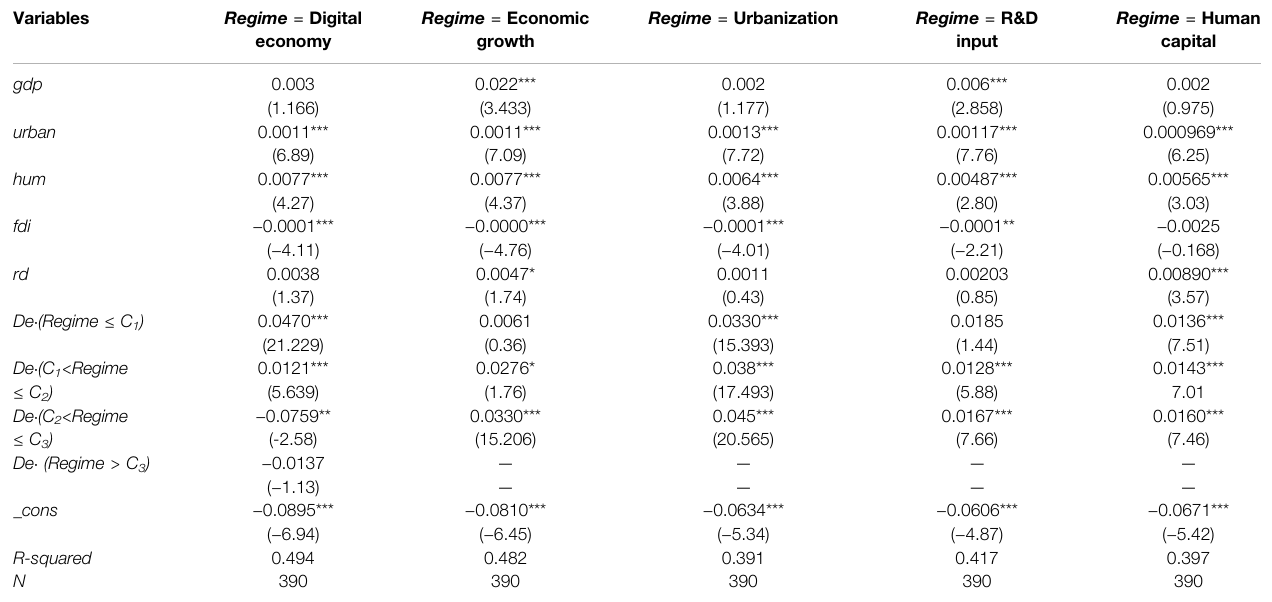
TABLE 11 | Threshold regression results for core explanatory variables.